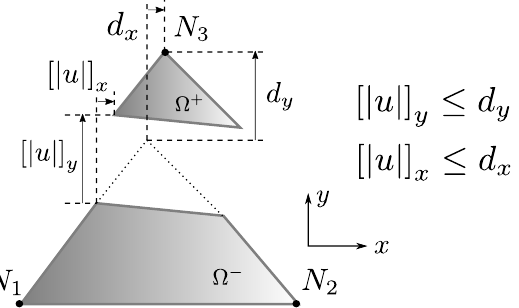
Figure 5. Example of kinematic consistency that should hold between the fracture displacement ] and the nodal displacement vector d for a constant stress u vector [ | |